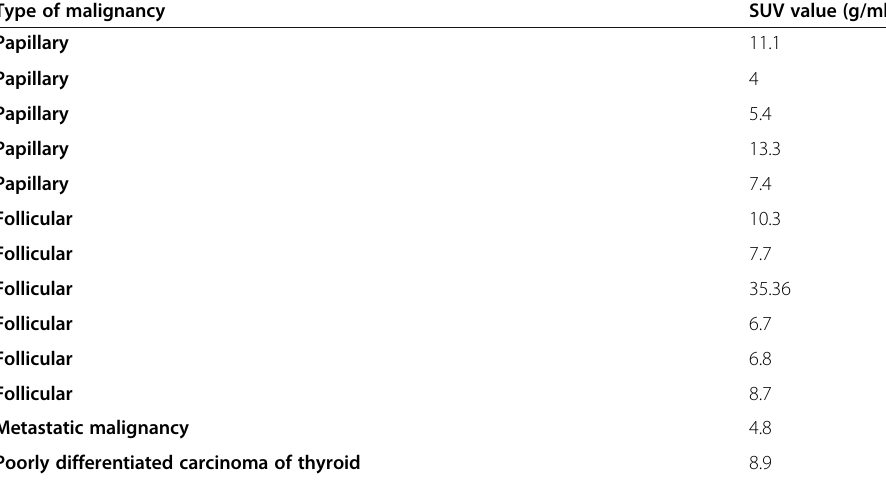
Table 1 The SUVmax values for the FNAC-proven malignancies Type of malignancy SUV value (g/ml) Papillary